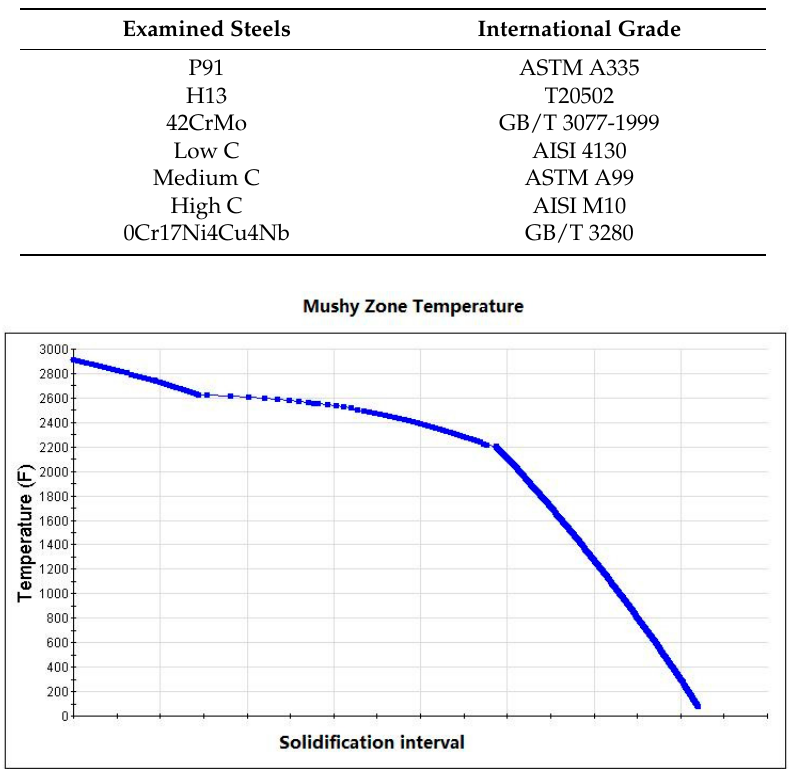
Table 4. International grades of the examined steels.